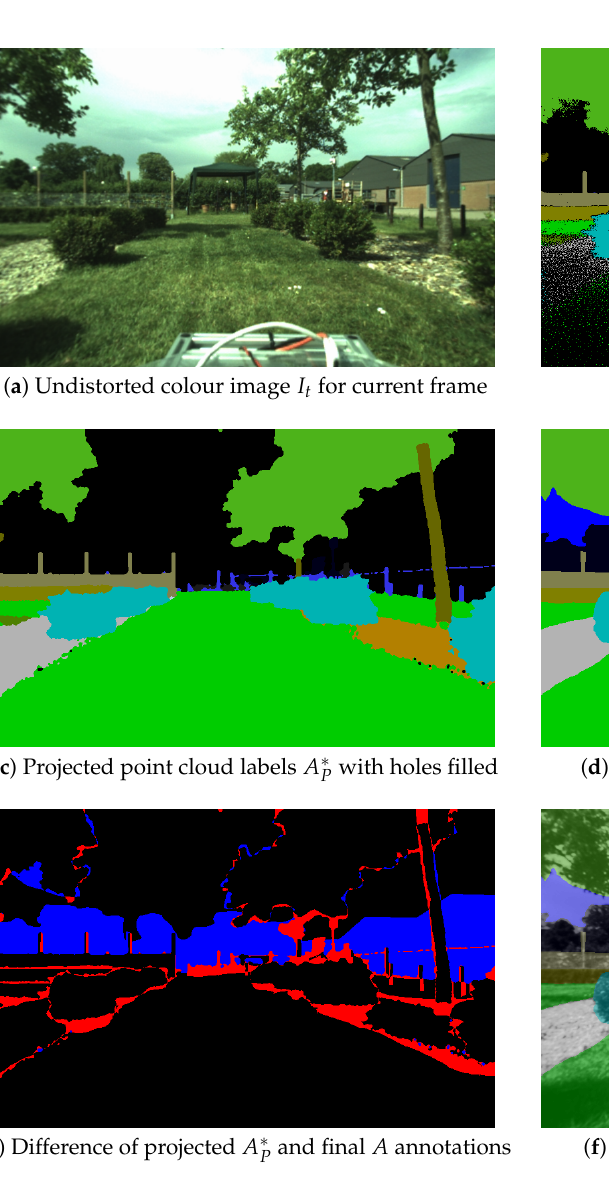
Figure 7. Annotation initialized from the projected semantic point cloud. Difference: Black colour indicates unchanged labels; red colour indicates manually-refined boundaries; blue colour indicates uninitialized background. The background was partially changed to sky and building labels by the